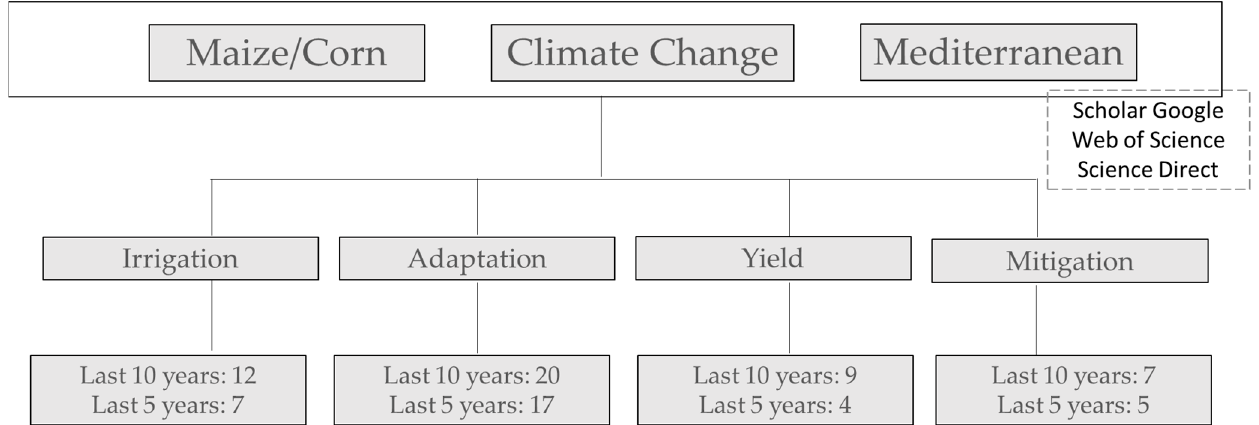
Figure 1. The keywords used in the present study to select peer-reviewed papers, and the number of the selected papers according to the selection criteria.